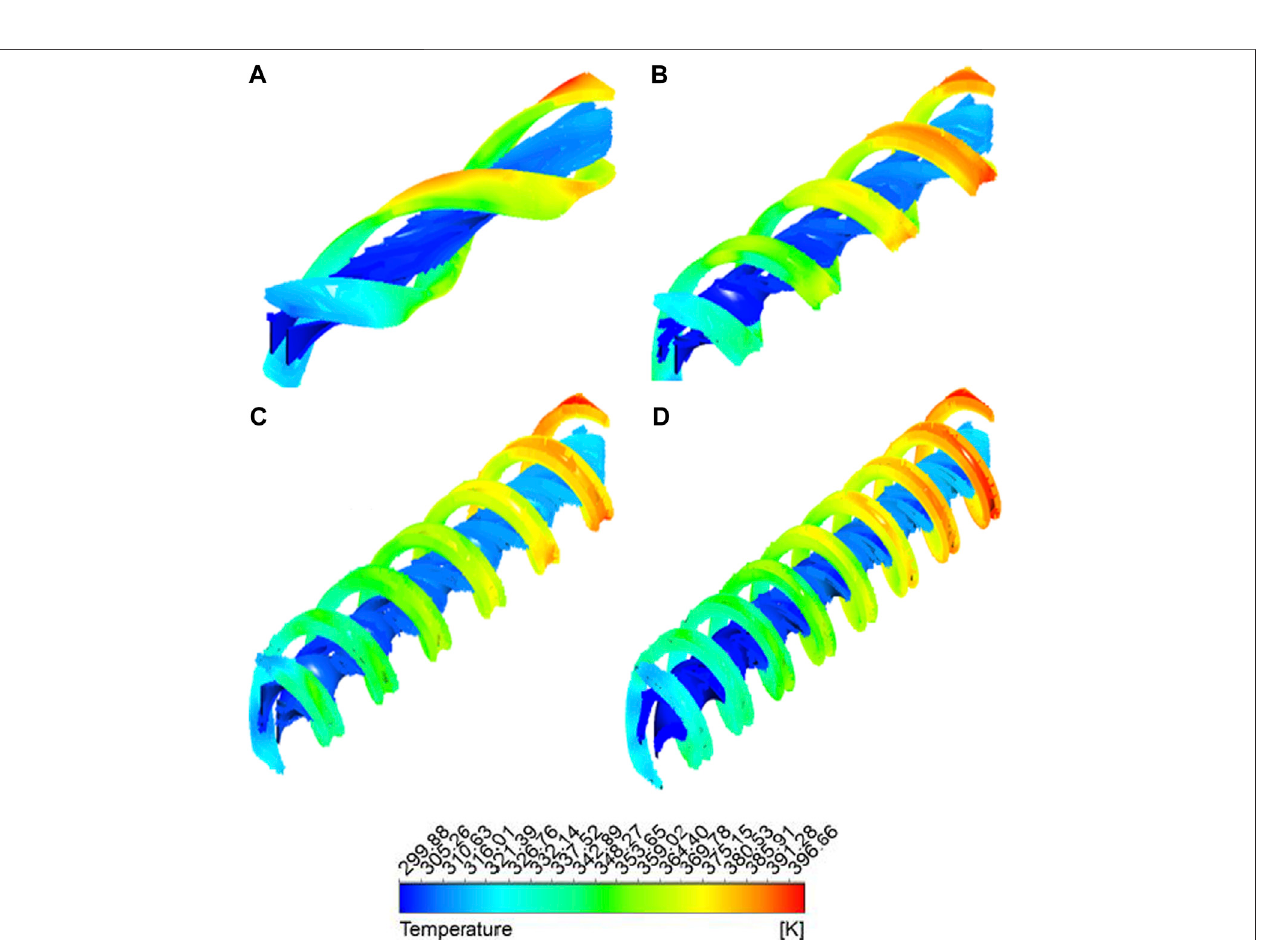
FIGURE 7 | The distribution of temperature at torsion ratios of (A) n (cid:1) 1, (B) n (cid:1) 2, (C) n (cid:1) 3, and (D) n (cid:1) 4.